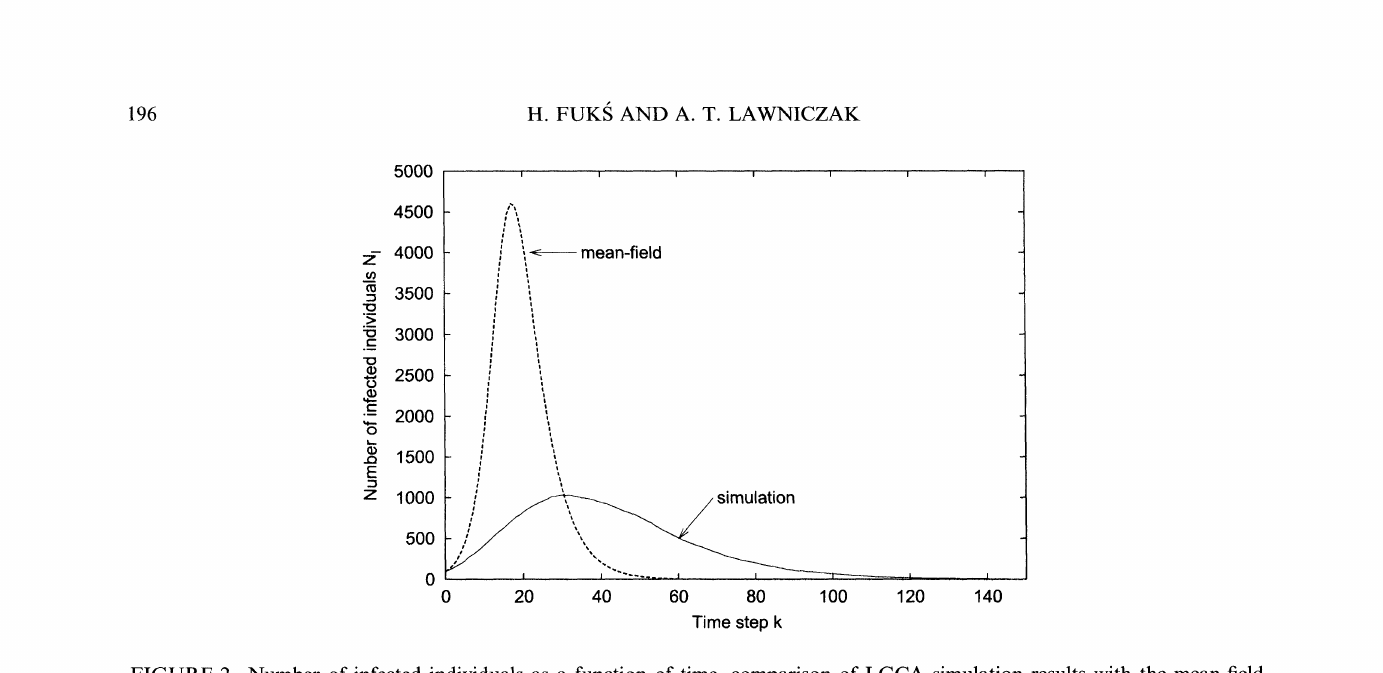
FIGURE 2 Number of infected individuals as a function of time, comparison of LGCA simulation results with the mean-field approximation. The simulation curve represents average of 50 LGCA experiments. Each LGCA simulation has been performed on a hexagonal lattice with 104 nodes with r=0.3, a=0.2, and with 16000 susceptibles and 100 infected individuals uniformly and randomly distributed on the lattice at k